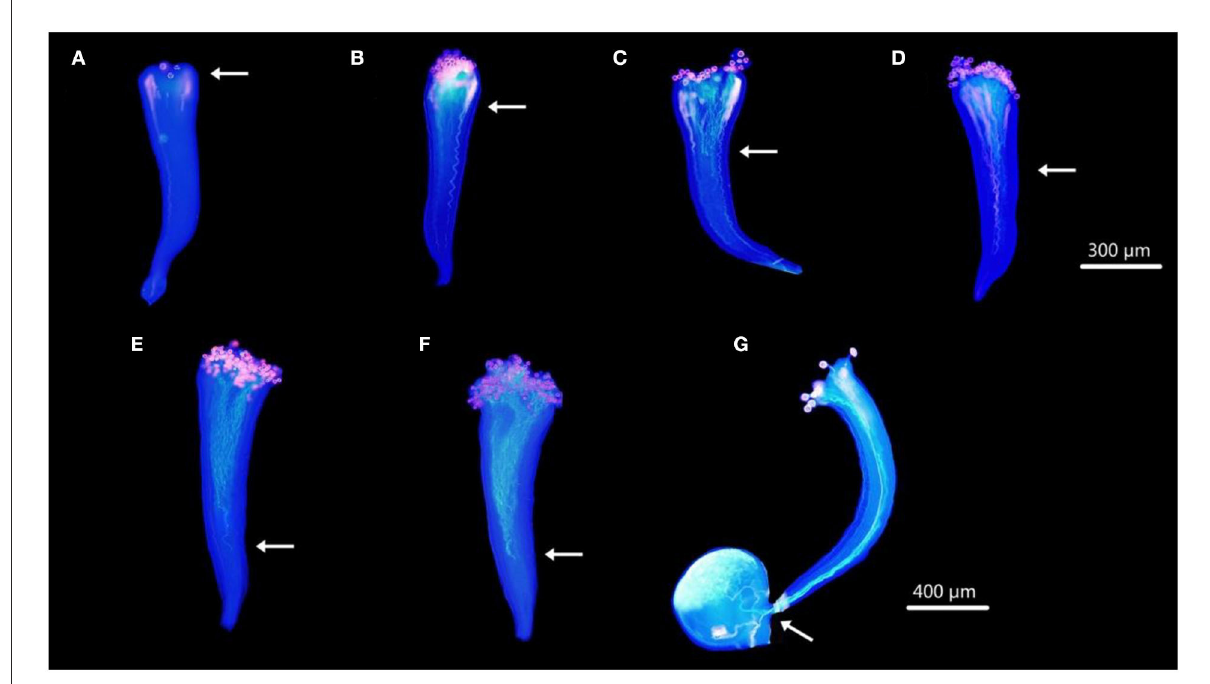
FIGURE1 Dynamic development of pollen tubes in pistils under SP. (A–F) Styles of F. viridis at 1, 6, 12, 18, 24, and 48 HAP, respectively. (G) Pistil of F. vesca at 24 HAP. White arrows indicate the positions at which the majority of the pollen tubes were arrested in pistils. Bars (A–F) = 300 µ m, (G) = 400 µ